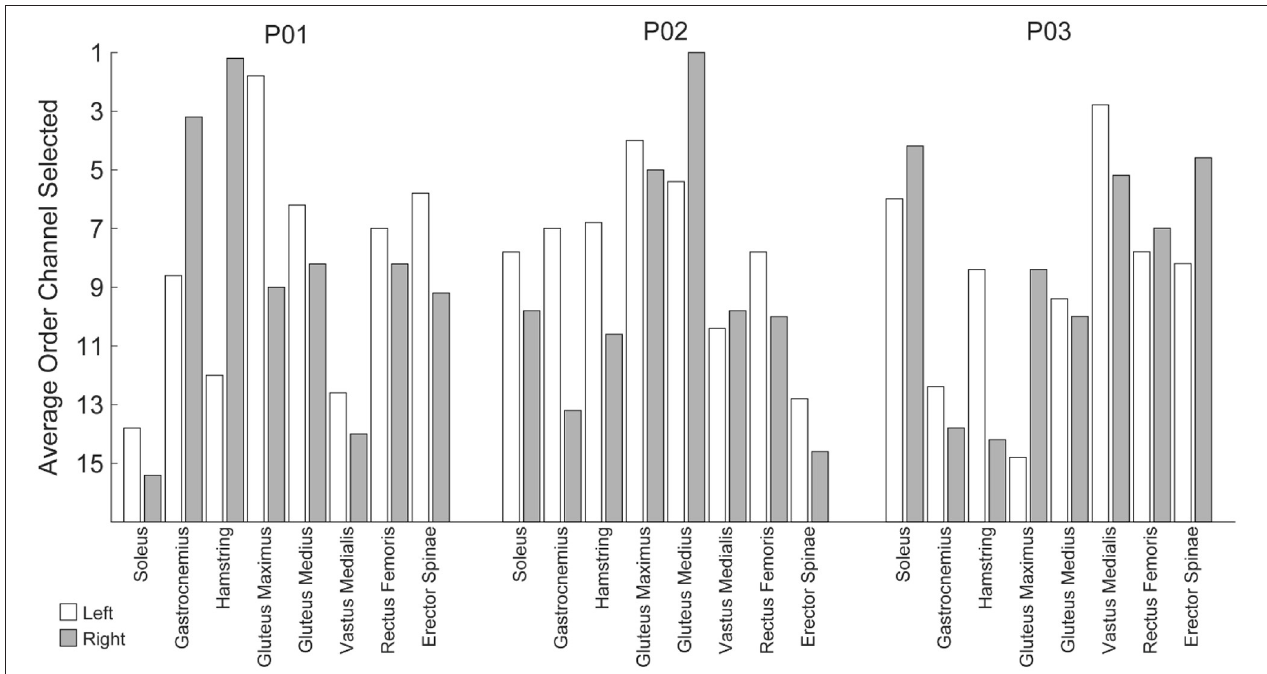
FIGURE 10 | Average order in which EMG channels were selected when using a step-wise Gram-Schmitt channel-selection algorithm. The order channels were selected was unique per participant and generally resulted in bilateral pairs from a subset of muscle groups as opposed to maximizing unilateral independent muscle